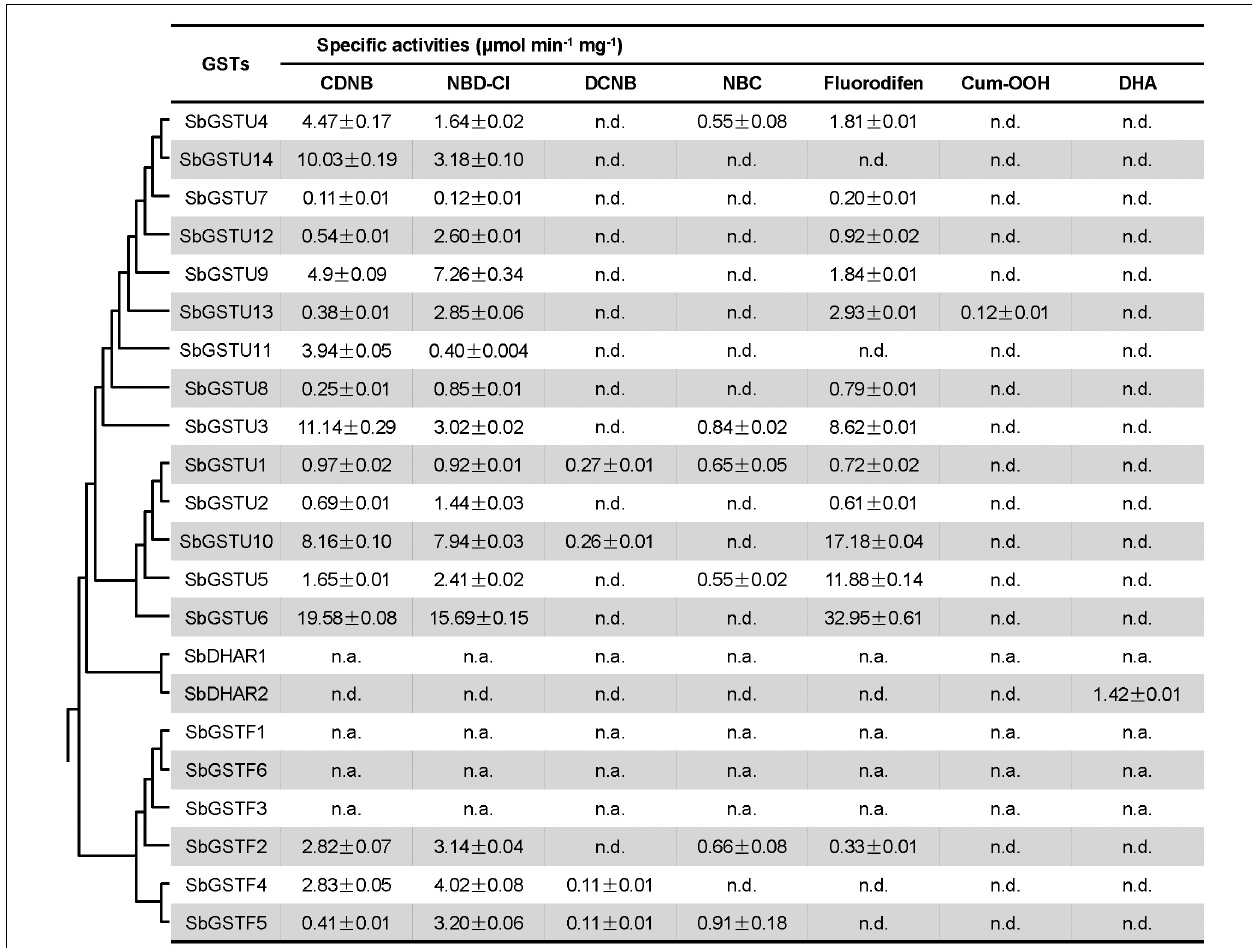
FIGURE 5 | Enzymatic activities of Salix GSTs. The phylogenetic tree is from Figure 1 . Values of enzymatic activities to different substrates are means ± SD as calculated from three replicates. n.d., no activity detected; n.a., not assayed.